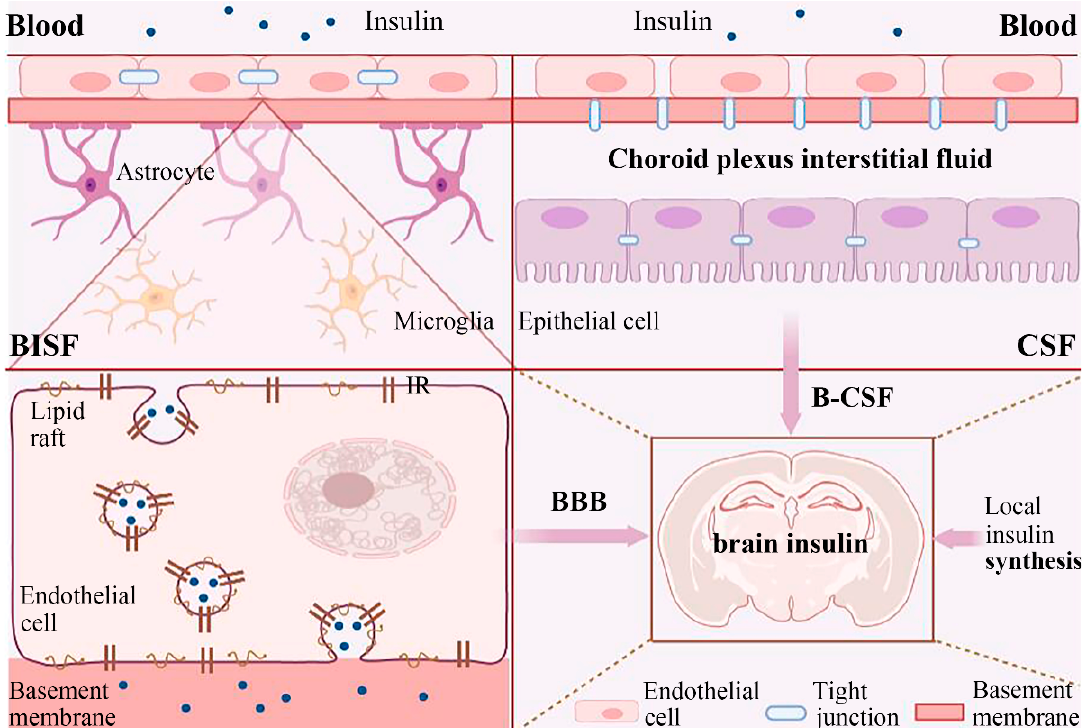
Figure 1. Schematic diagram showing the possible sources of brain insulin. First, the BBB is composed of a capillary basement membrane, pericytes, astrocytes, and specialized capillary endothelial cells that are interconnected with tight junctions. Peripheral insulin can cross the BBB intact through IR-specific vesicle-mediated transport in endothelial cells. Second, the B-CSF barrier has fenestrated capillaries in the choroid plexus that lack tight junctions and allow para- and trans-cellular transport across the endothelium. The B-CSF barrier is another possible route for insulin to enter the CNS. Third, there is some limited evidence suggesting the possibility of de novo insulin synthesis in the brain. BBB: blood-brain barrier, BISF: brain interstitial fluid, CSF: cerebrospinal fluid; IR: insulin receptor.